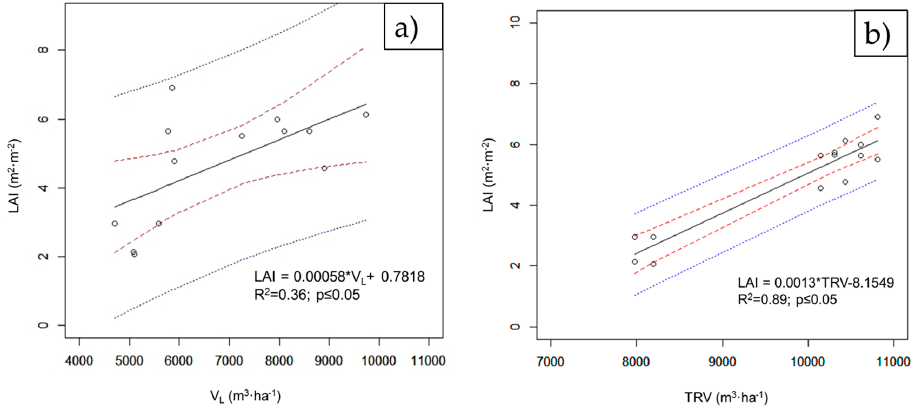
Figure 5. Linear correlations between ( a ) LAI and V L and ( b ) LAI and TRV.